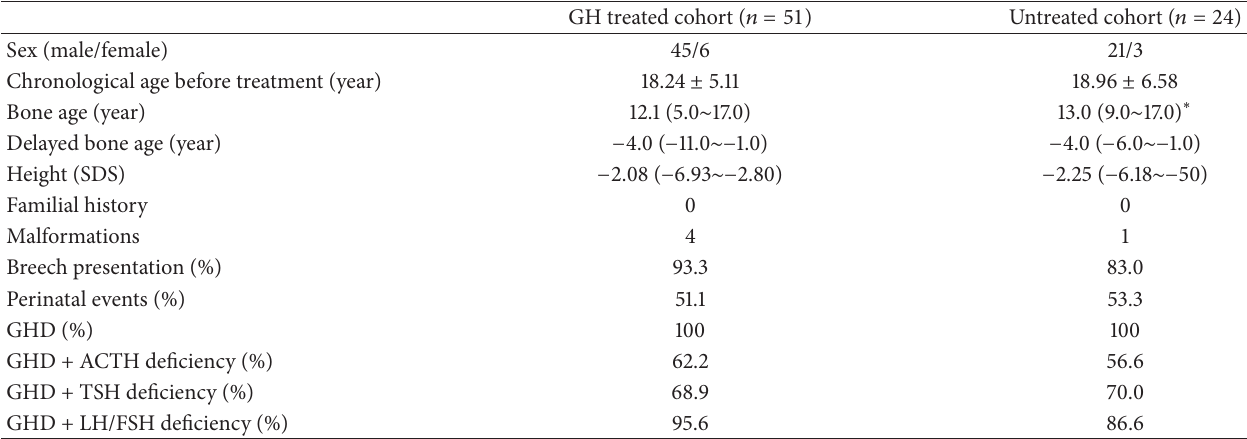
Table 1: Initial characteristics of the 75